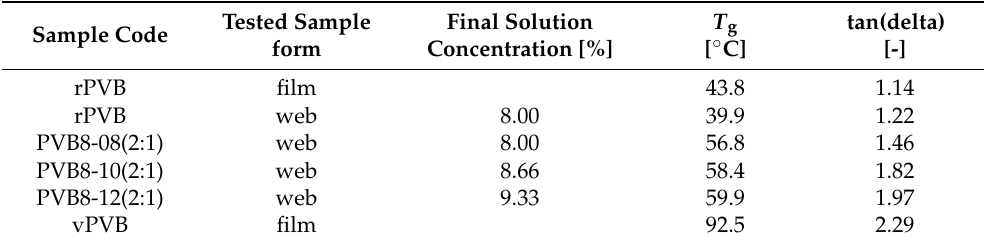
Table 6. Evaluation of T g from DMA measurements for rPVB and blended PVB nonwoven nanofi- brous webs, and rPVB and vPVB